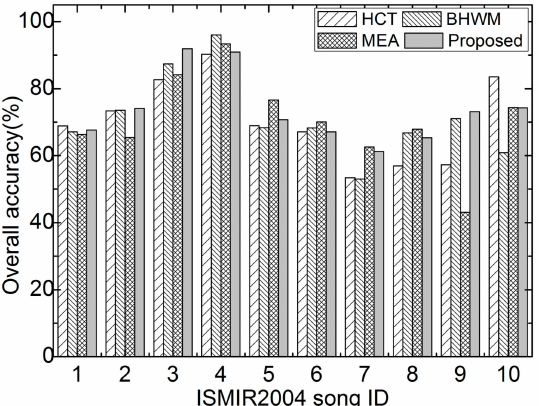
Figure 8. Overall accuracies of different methods on